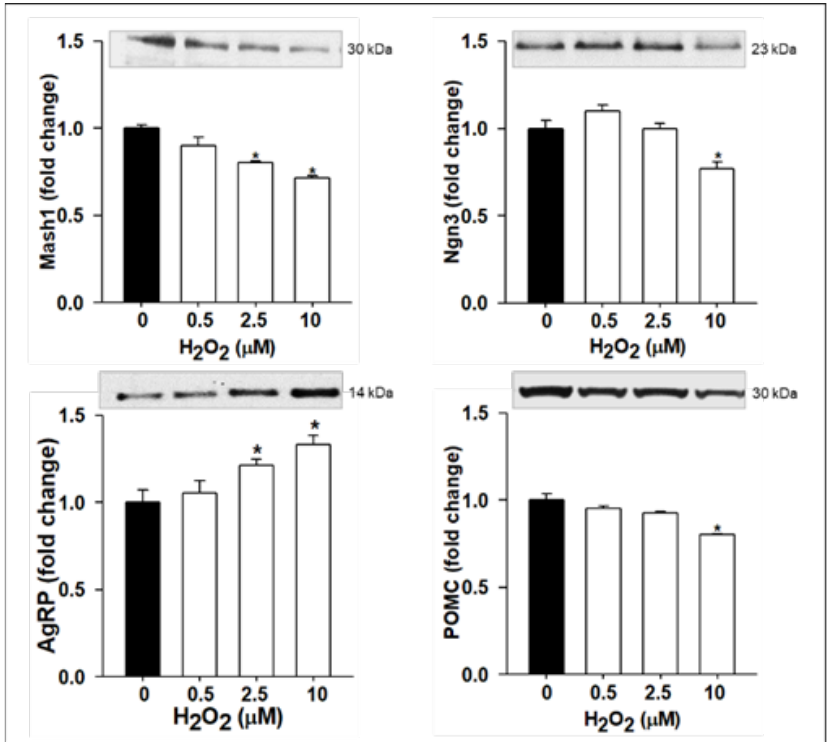
Figure 5. H 2 O 2 Reduces NPC Proneurogenic bHLH Genes and Alters Neuropeptide Expression. Hypothalamic NPCs were treated with various doses (0.5, 2.5, and 10 µ M) of H 2 O 2 in differentiation medium for 24 h. Values are (Mean ± SEM of n = 4 independent experiments with each treatment performed in duplicate) normalized to untreated control cells and expressed as fold change. For protein expression, representative immunoblots are shown. * p < 0.05 vs. untreated cells.